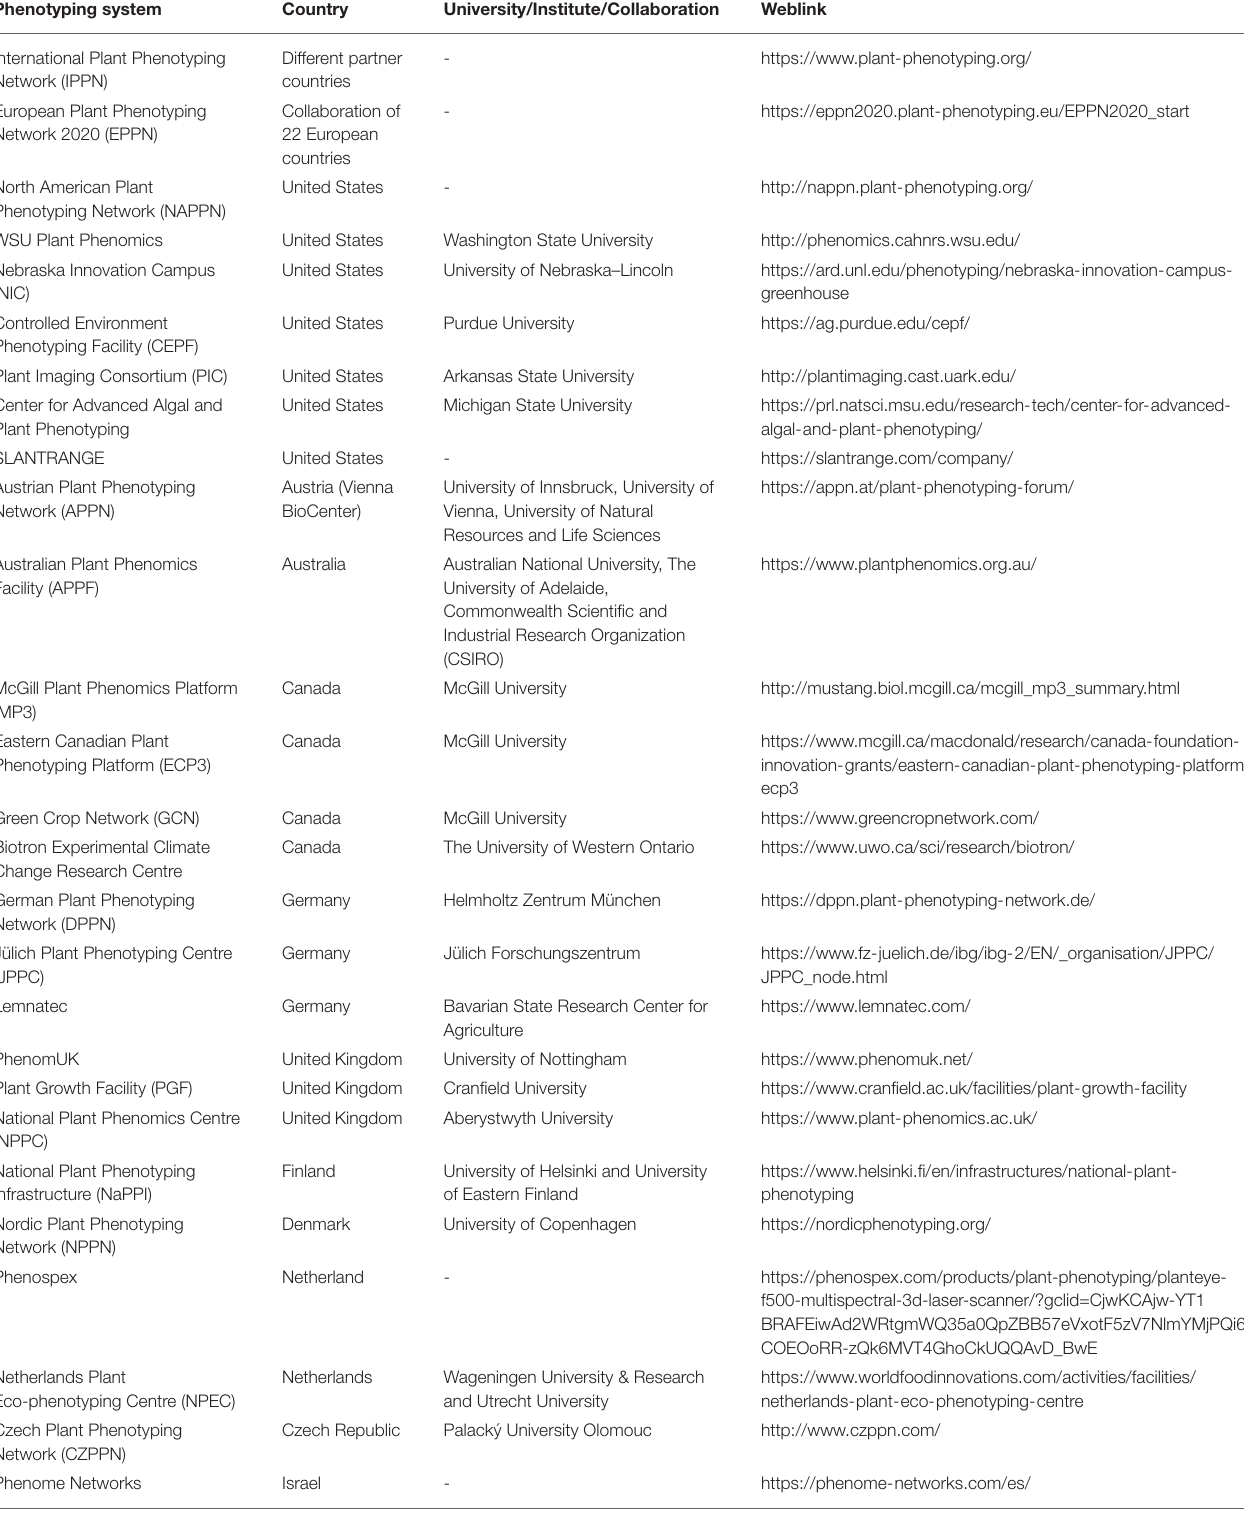
TABLE 5 | List of major globally available high-throughput phenotyping facilities. Phenotyping